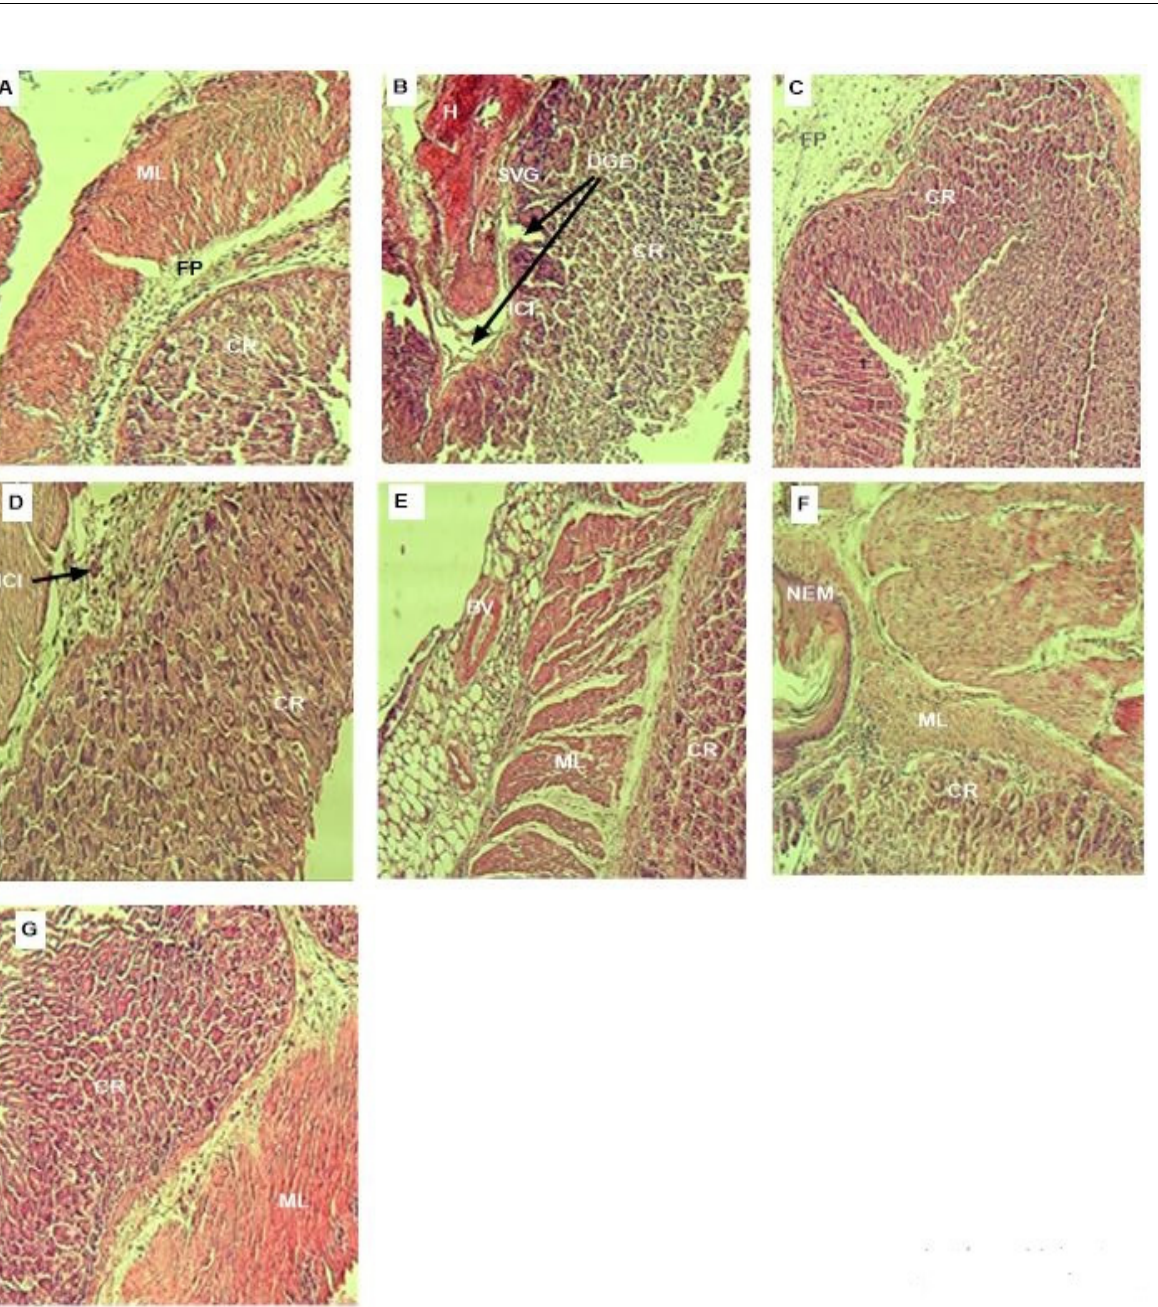
Figure 6. Histological examination of mice stomach tissues in Ethanol-induced gastric damage model (H&E stain × 100). ( A ) Normal control shows normal morphology of mucosal epithelium ( B ) ethanol-control, ( C ) omeprazole (20 mg/kg), ( D ) RAE extract (200 mg/kg), ( E ) RAE extract (400 mg/kg), ( F ) RME extract (200 mg/kg), ( G ) RME extract (400 mg/kg). CR: corpus. FP: fatty part. ML: muscle